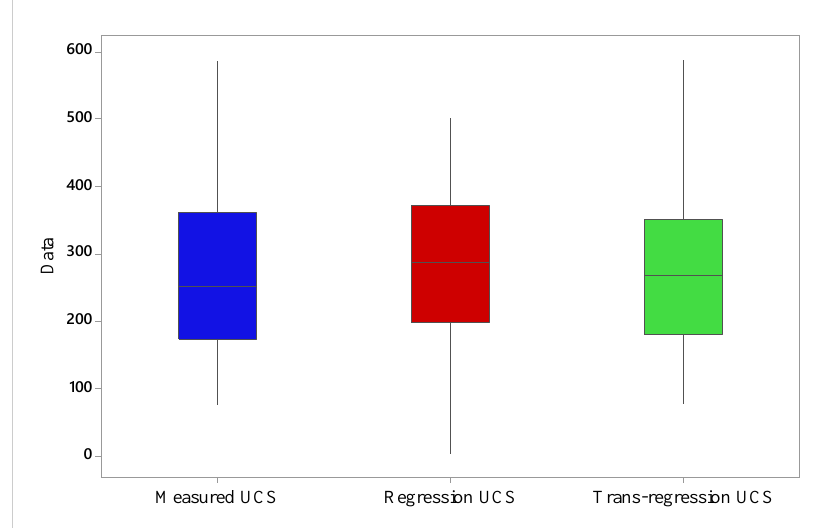
Fig. 4. Box plot of measured data vs regression and the transformed regression